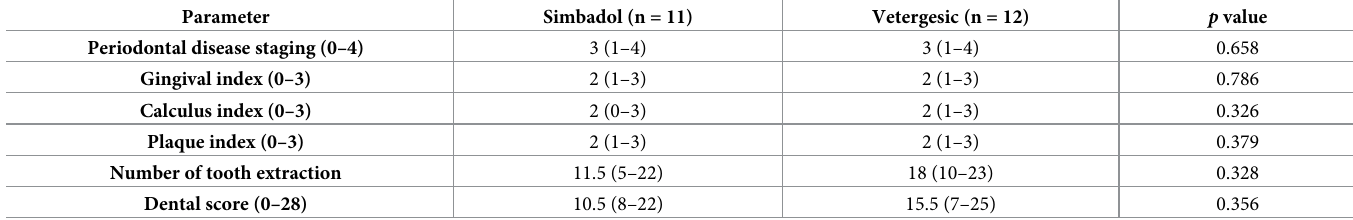
Table 3. Dental parameters including periodontal disease staging, gingival, calculus and plaque index, number of tooth extractions and dental score. Values are expressed as median (range).